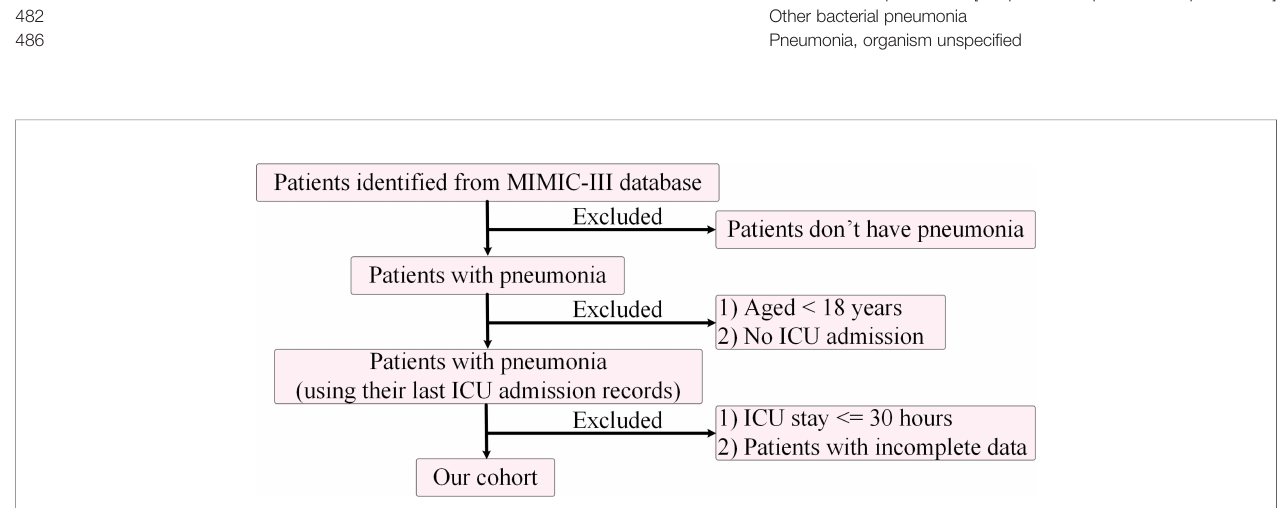
FIGURE 2 | The fl owchart of pneumonia patient selection from the MIMIC-III database.